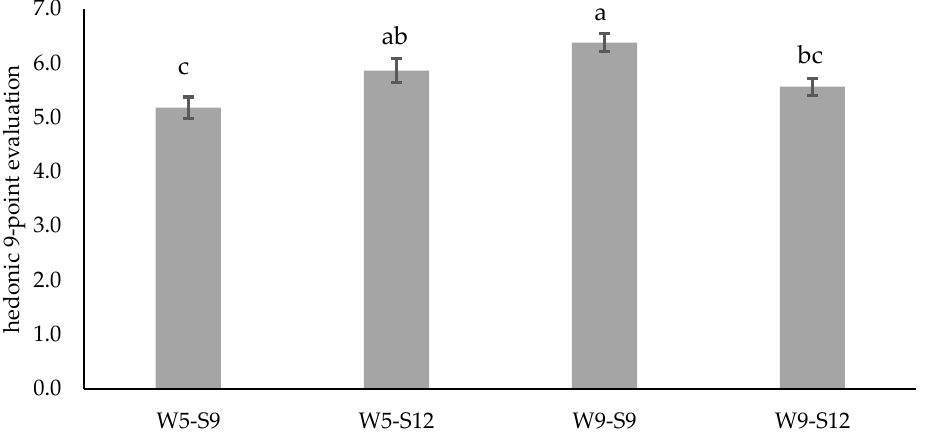
Figure 2. Hedonic evaluation of the four types of meats presented anonymously. Results are expressed as mean and standard error. Bars with different letters are different ( p < 0.05).